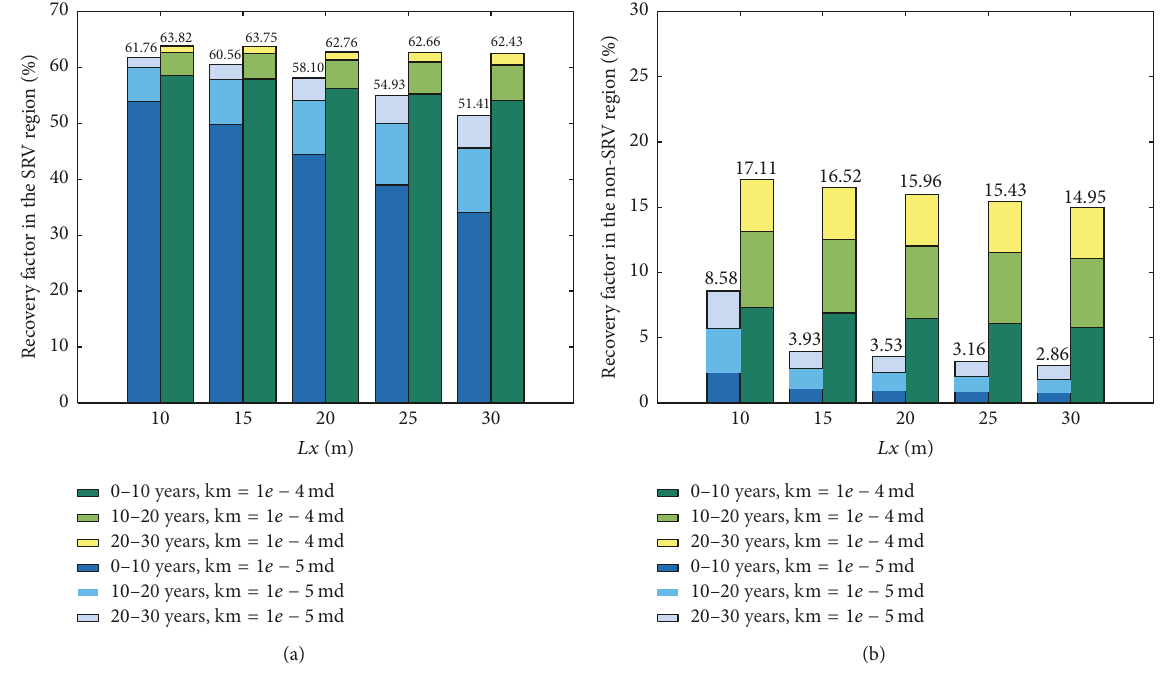
Figure 8: The effect of secondary fracture network density on the recovery factor: (a) SRV region and (b) non-SRV region.